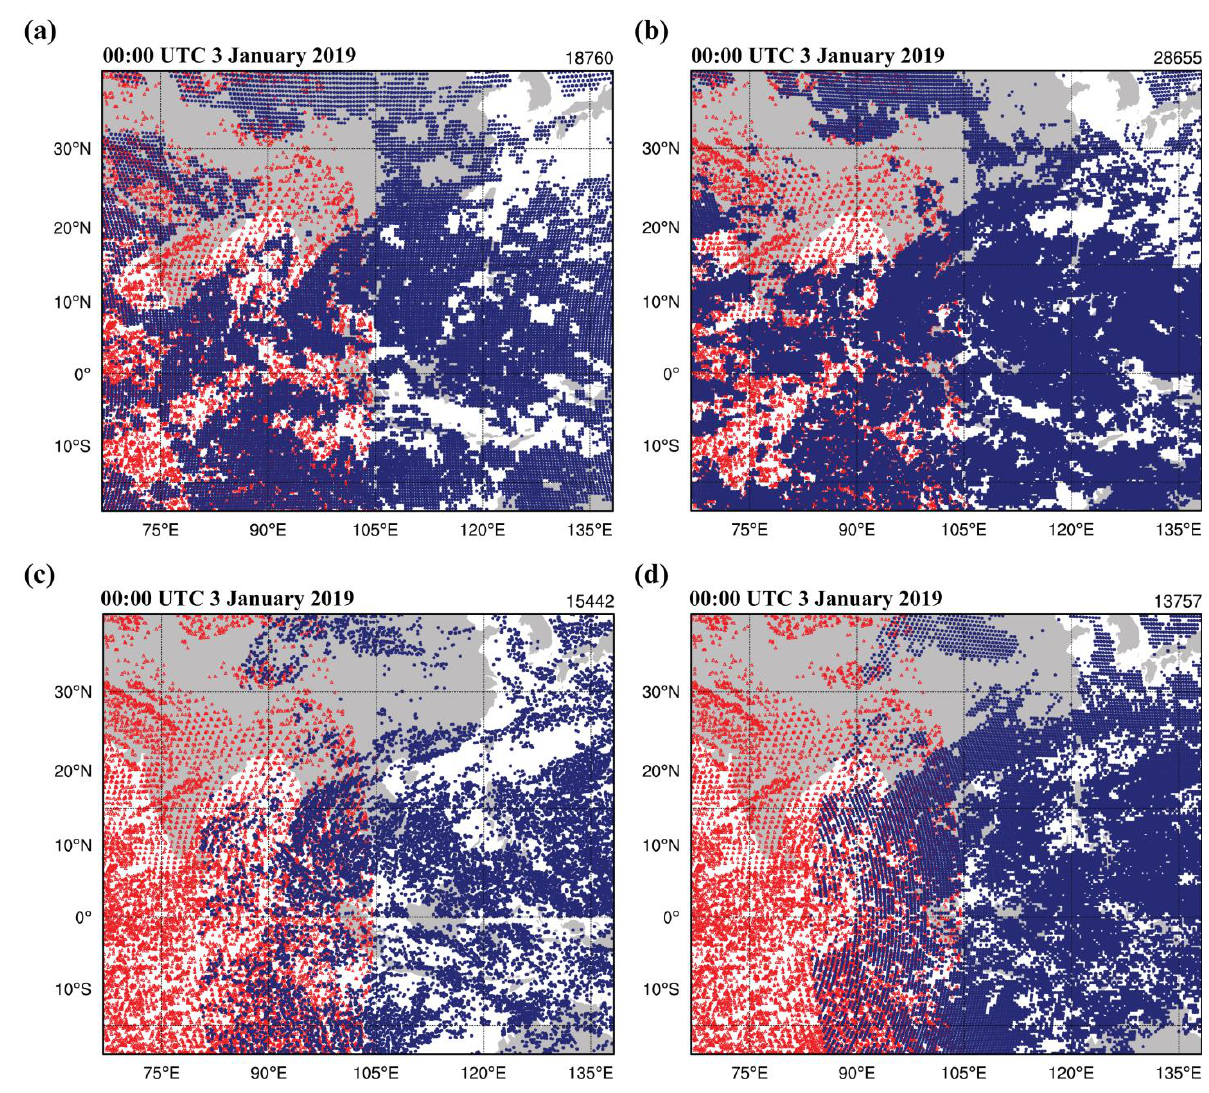
Figure 1. Examples of the horizontal distributions of all IR and WV channel’s AMVs data coverage plots over the research domain derived from ( a ) FY-2G, ( b ) FY-4A, ( c ) HIMA-8 derived from CIMSS, and ( d ) HIMA-8 derived from NCEP PREBUFR file, plots in dark blue dots which were valid at 00:00 UTC on 3 January 2019. The red triangle dots denote the Meteosat- 8′ s AMVs, which also cover the western part of the domain. Topography is indicated by the grey colour.